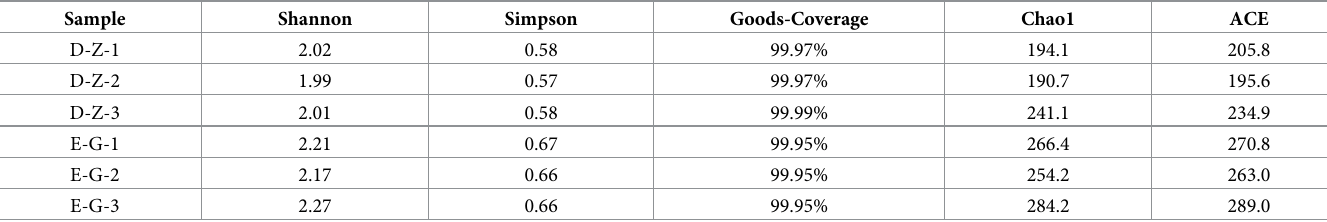
The proportions of Thermomyces , Thermoascus and Monascus in high-temperature Daqu were all larger than those in medium-temperature Daqu, indicating that these three microbial Table 2. Medium-temperature Daqu and high-temperature Daqu fungal diversity index table. Sample Shannon Simpson